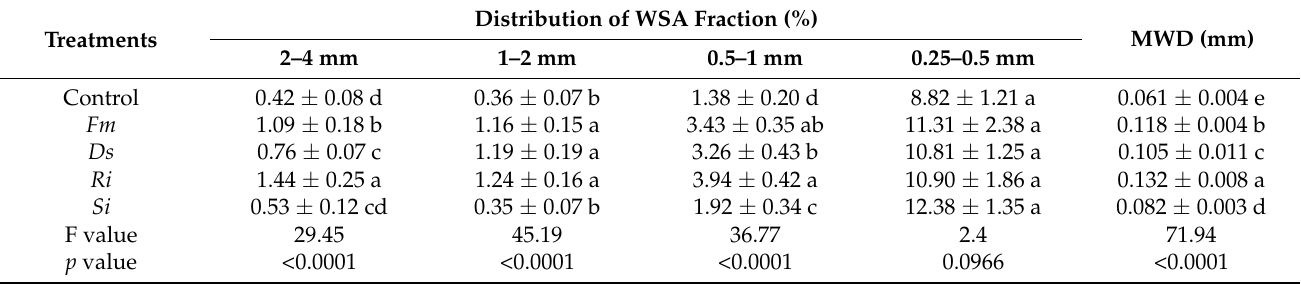
Figure 4. Effects of arbuscular mycorrhizal fungi and Serendipita indica on soil easily extractable glomalin-related soil protein (EE-GRSP), difficultly extractable glomalin-related soil protein (DE- GRSP), and total glomalin-related soil protein (T-GRSP) concentrations of Vicia villosa seedlings. Data (means ± SD, n = 4) followed by different letters above the bars indicate significant ( p < 0.05) differences. For abbreviations see Figure 1. Table 5. Effects of inoculation with different symbiotic fungi on the distribution of water-stable aggregates (WSAs) and mean weight diameter (MWD) of Vicia villosa